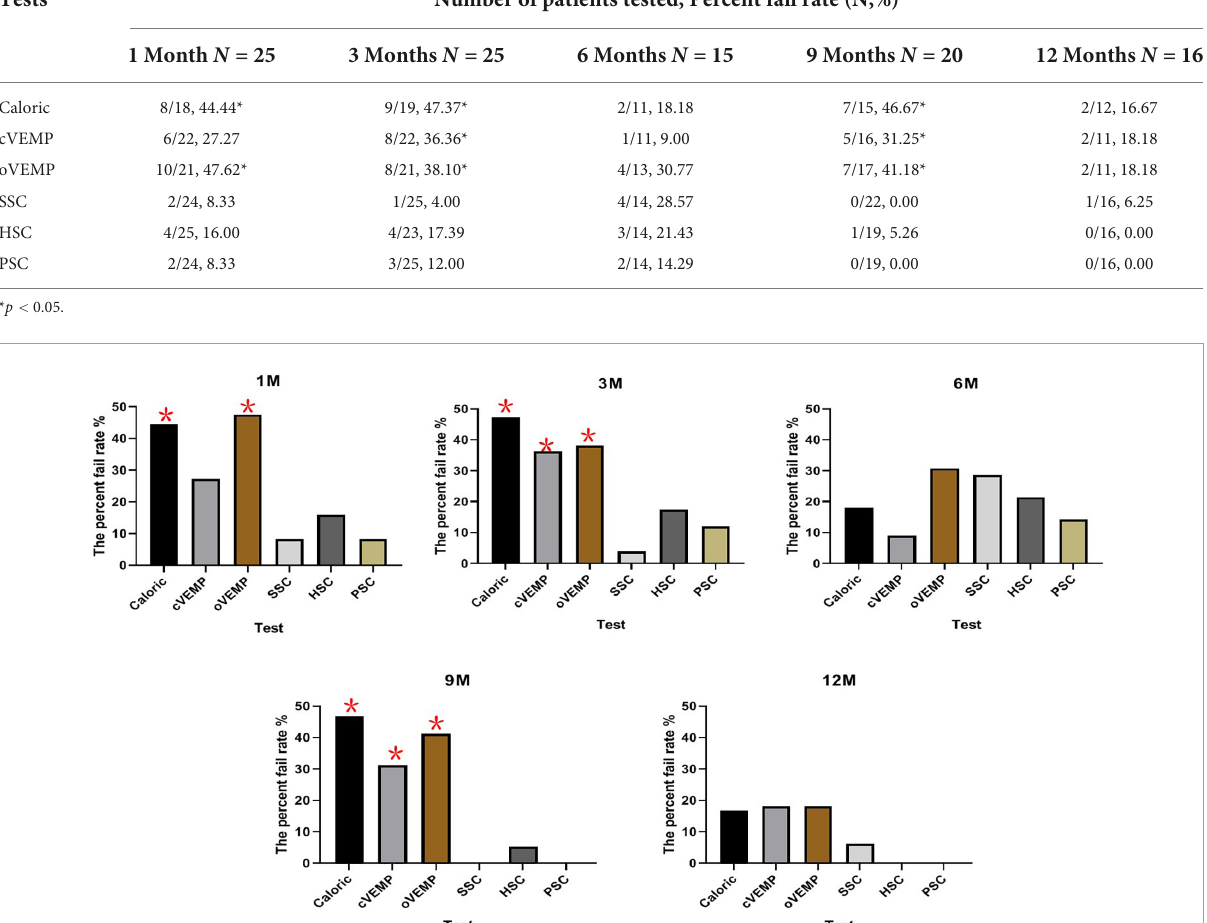
TABLE 3 The simultaneous comparison of percent fail rates of vestibular function on the implanted side at all time points.